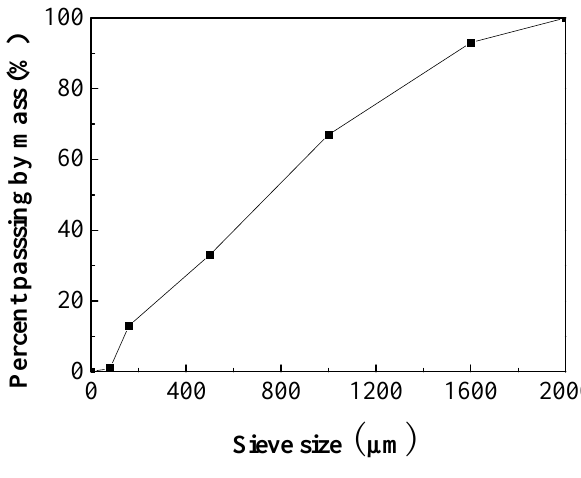
Figure 1. Grading curve of sand